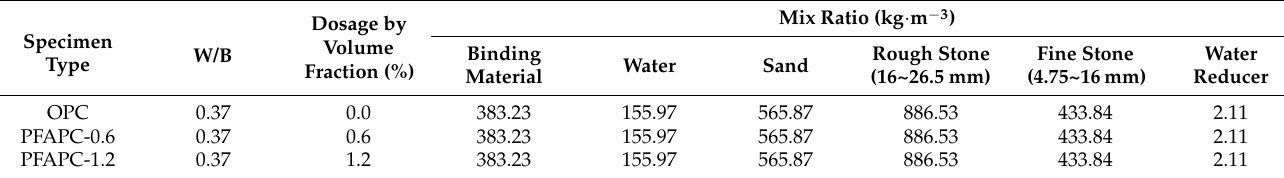
Table 3. Mix ratio of airport pavement